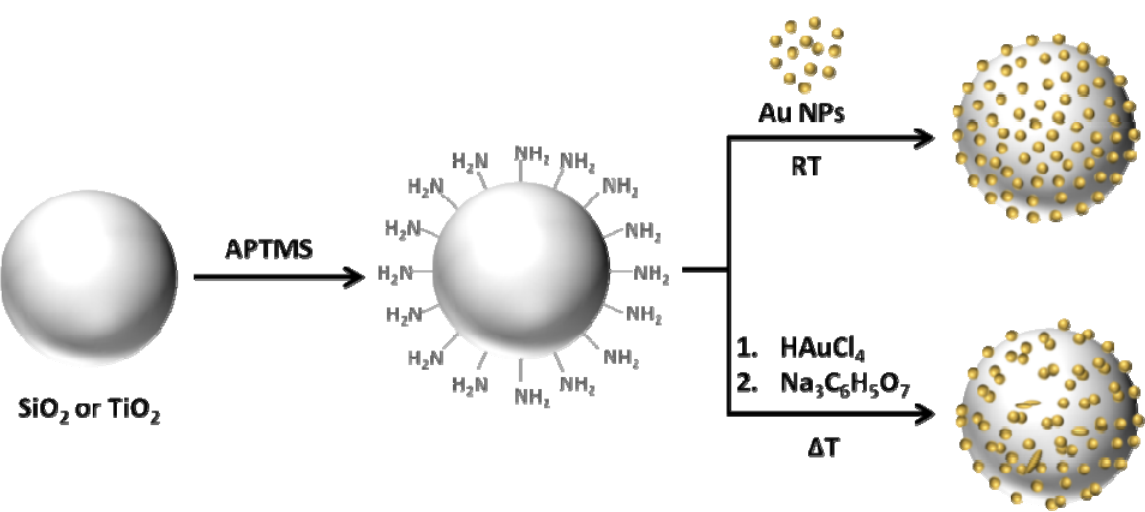
Figure 1. Schematic illustration of SiO 2 @Au and TiO 2 @Au core-shell